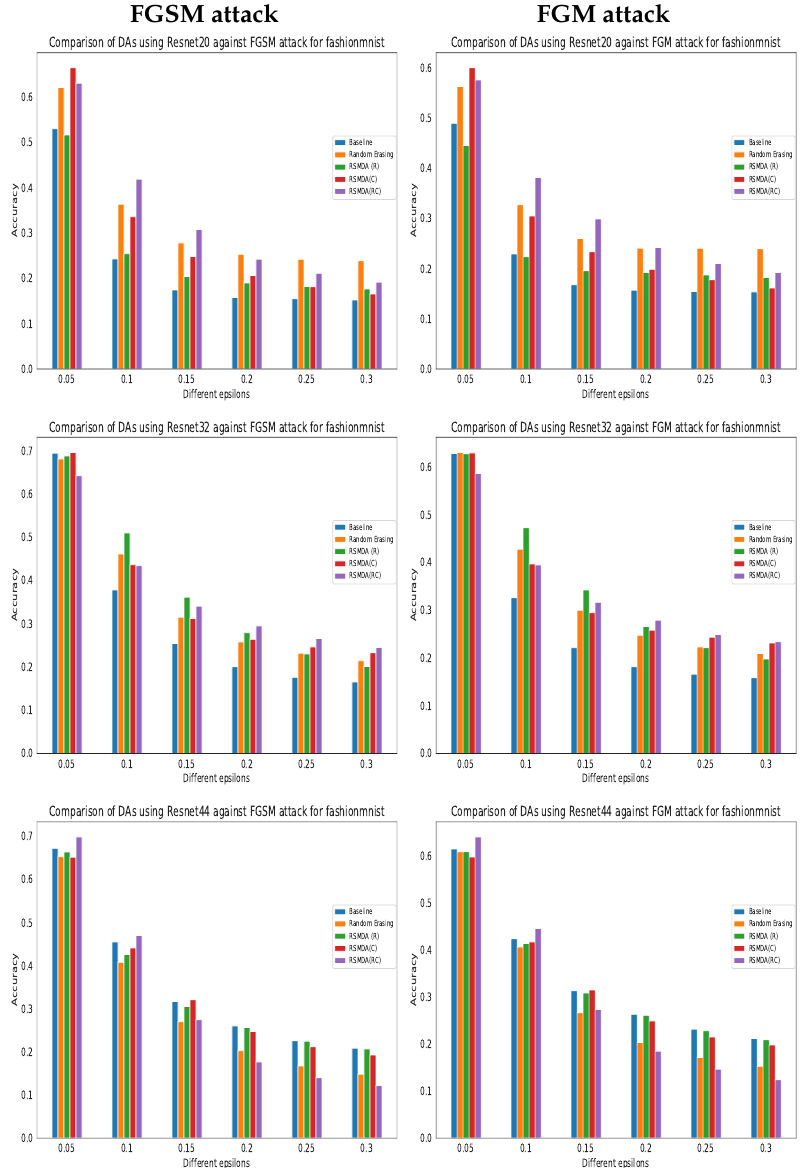
Figure 6. Comparison of DAs against different adversarial attacks for fashionMNIST dataset using different